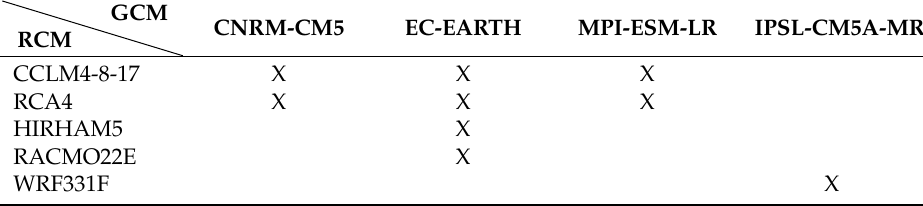
Table 2. Regional climatic models (RCMs) and global climate models (GCMs) considered. GCM RCM